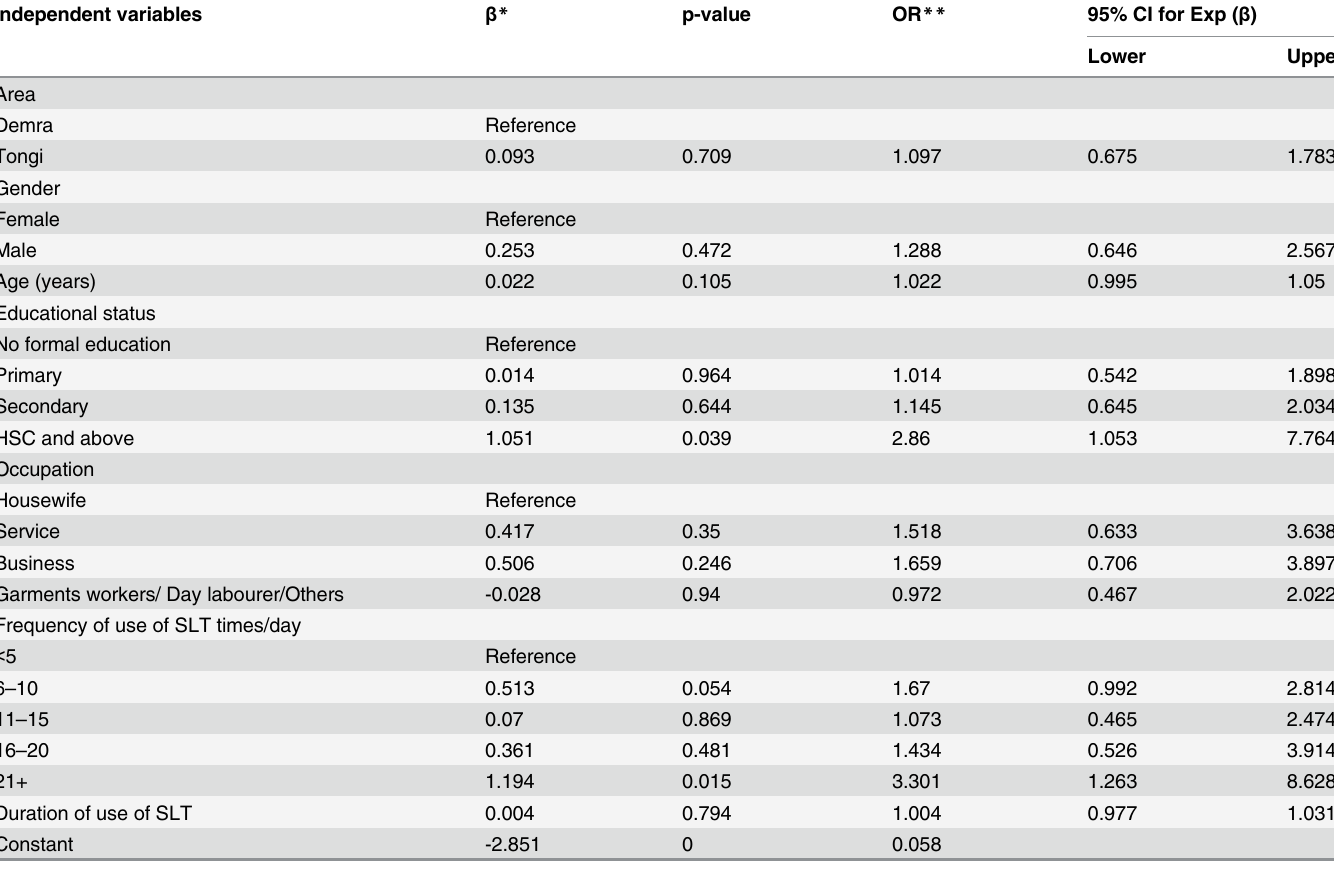
Table 4. Results of logistic regression with smokeless tobacco habit related